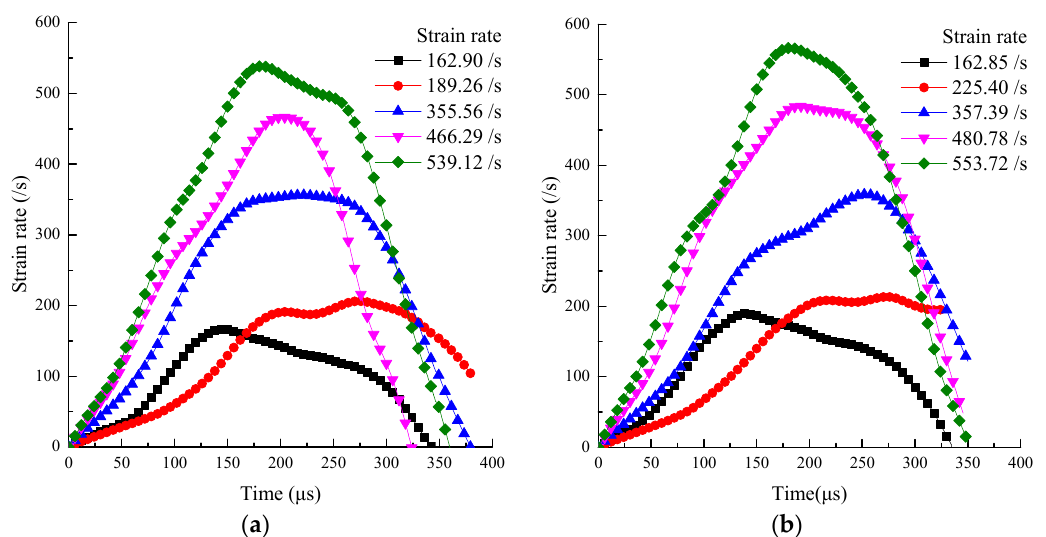
Figure 7. Strain rate time history curve: ( a ) Mortar , ( b ) Concrete.